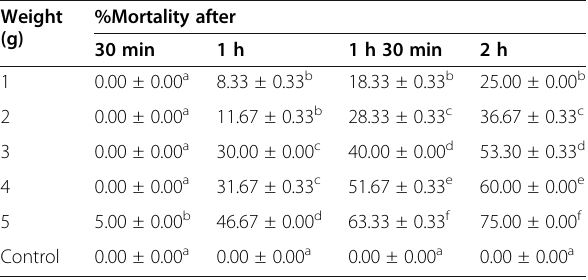
Table 3 Fumigant toxicity of synergistic application of Petiveria alliacea leaf and root bark powder on the mortality of adult Culex quinquefasciatus Weight %Mortality (g)